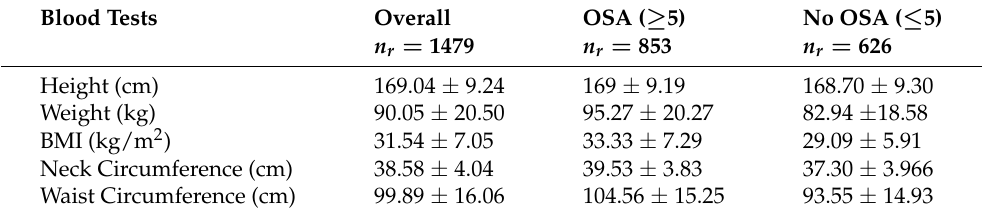
Table A3. Blood test profile characteristics of cohort expressed as mean ± standard deviation.